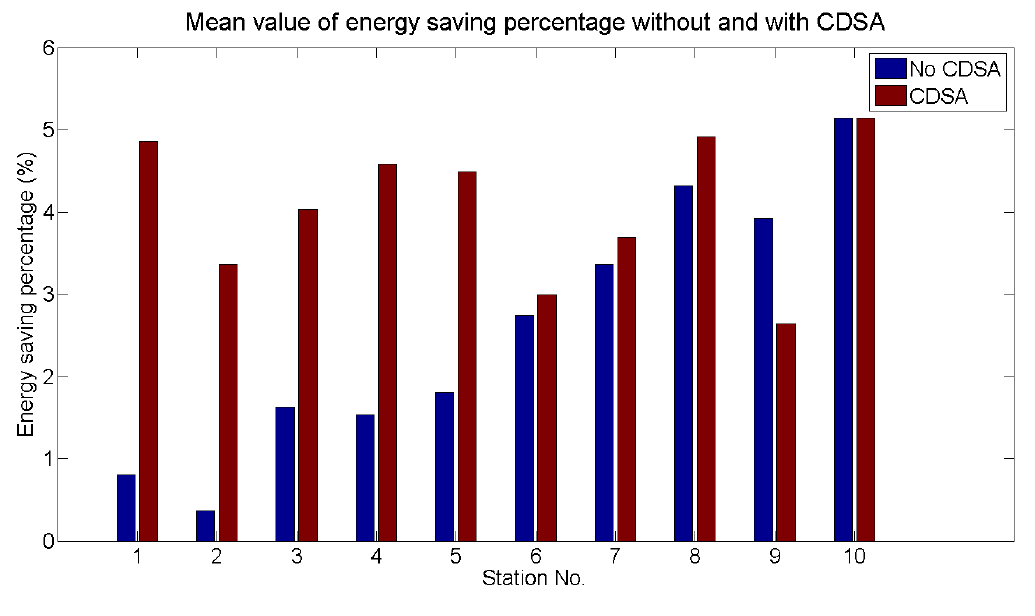
Figure 14. Average energy-saving effect with and without CDSA among different